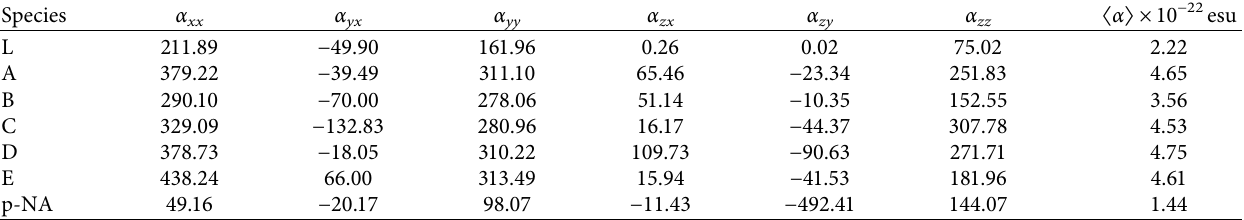
Table 9: Static average isotropic polarizabilities ( 〈 α 〉 ) alongside some of its components for L, transition metal complexes, and p-NA, calculated at ω � 0 at the wB97xd/6-311++G level of theory.